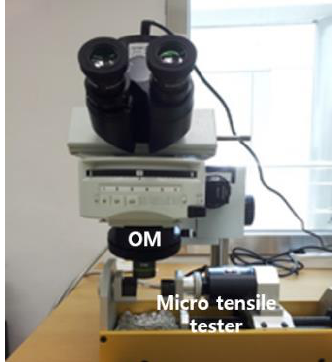
Figure 2. Single-fiber pullout test